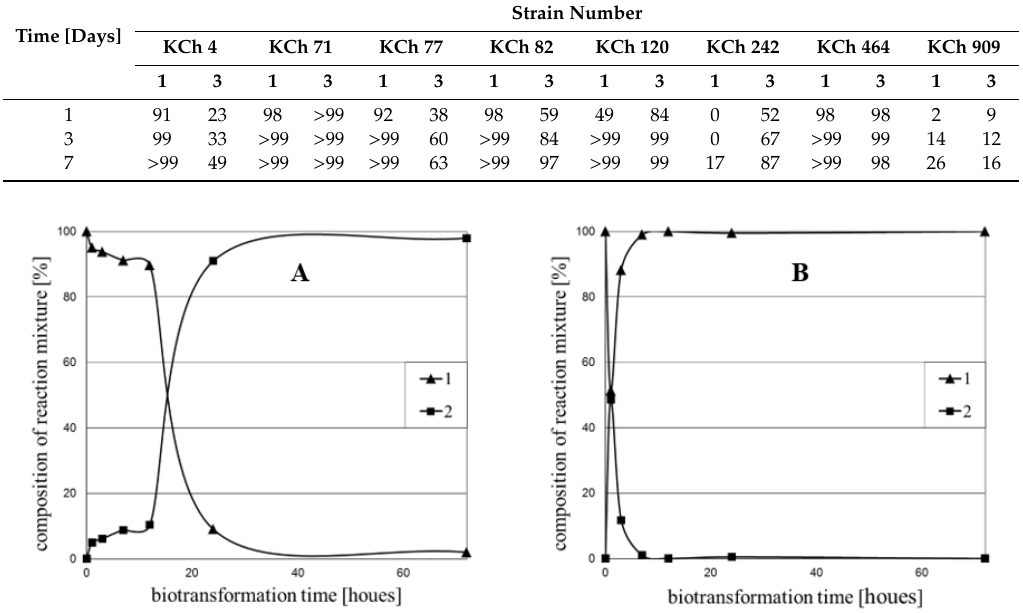
Figure 1. Time dependence of the transformation of chalcone ( 1 ) in the culture of: ( A ) Rhodotorula rubra KCh 4; ( B ) Yarrowia lipolytica KCh 71.